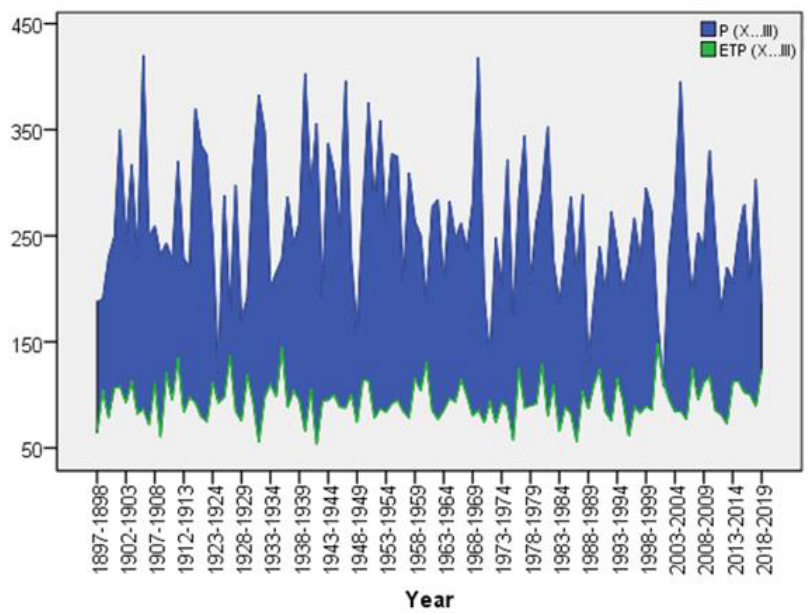
Figure 17. High – Low chart by difference area between cumulative values during the cold period of the year, October (X) to March (III) of precipitation (P X-III) and evapotranspiration (ETP X-III), expressed in mm, recorded annually at the Regional Meteorological Center Banat-Crisana, Romania, 1898-2019.